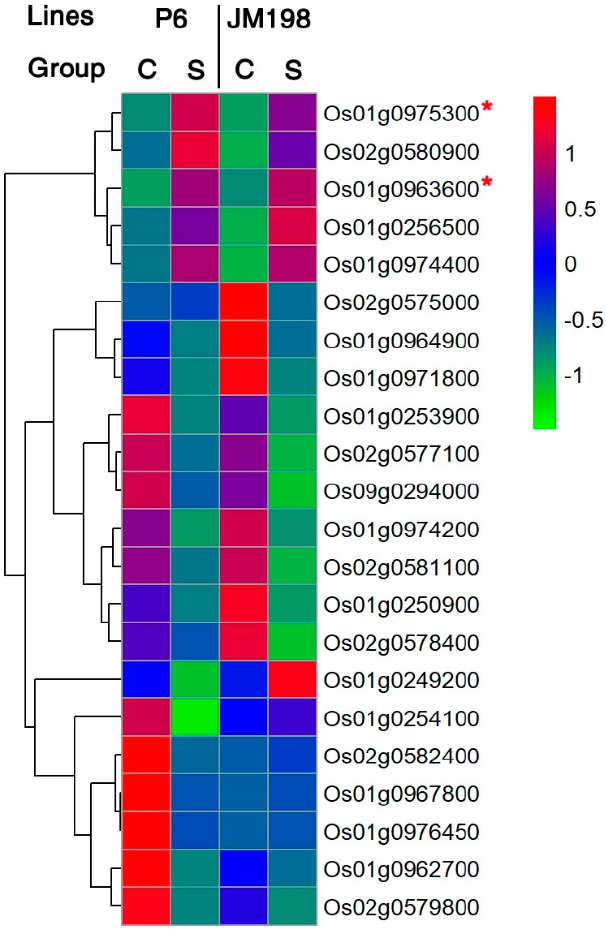
Figure 4. Gene expression analysis of 22 candidate genes related to salt tolerance between P6 and JM198. C: control group, S: salt stress group, *: Commonly upregulated DEGs in both P6 and JM198 located in the target regions of qDTS1-2 . Table 3. Differentially expressed candidate genes in P6 and JM198 under salt stress